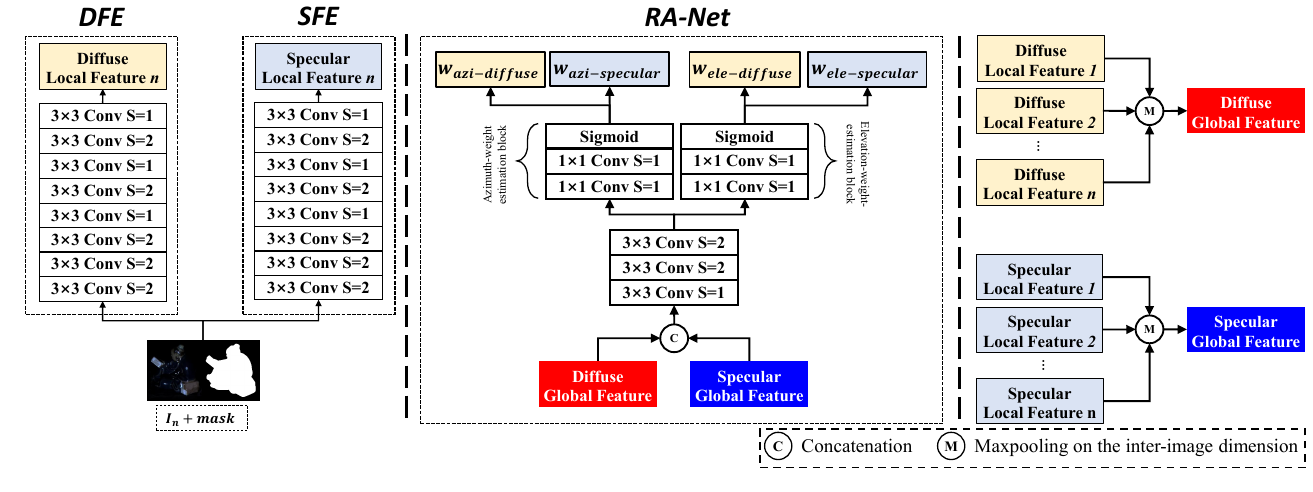
Figure 3. The proposed reflectance decomposition (ReD) module. Left: the network structure of the diffuse feature extractor (DFE) and specular feature extractor (SFC). Middle : The network structure of the reflectance-aware network (RA-Net). Right : Schematic diagram of the acquisition of global